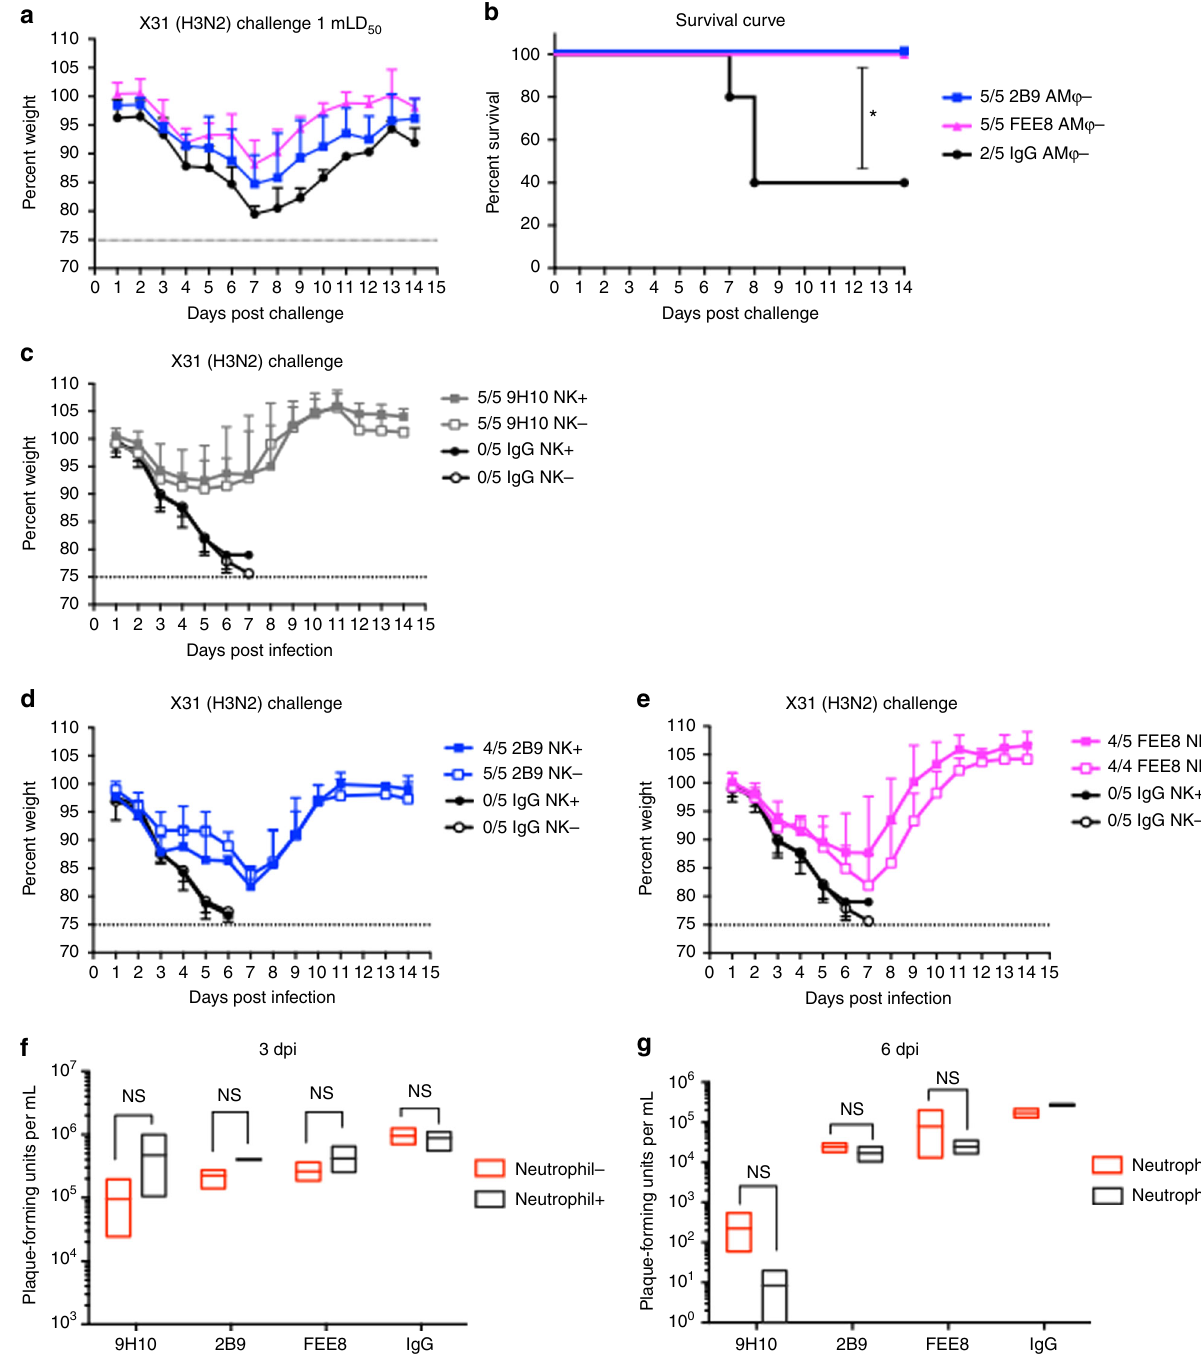
Fig. 4 NK cells and neutrophils do not play signi fi cant roles in murine nonNAb-mediated protection. a , b BALB/c mice depleted of AM φ were administered IP with 2B9, FEE8, or IgG, and then challenged IN with 1 mLD 50 of X31 virus. c – e C57BL/6J mice were treated IP with mAb PK136 to deplete NK1.1 cells. Control mice received PBS. Mice received 15 mg per kg of ( c ) 9H10, ( d ) 2B9, or ( e ) FEE8 IP 5 hours before a challenge with 5 mLD 50 of X31. The ratios in the fi gure legends indicate the number of animals that survived challenge over total number of animals per group ( n = 4 or 5). A mAb against GST was used as an IgG control. f , g BALB/c mice were treated with mAb 1A8 to deplete neutrophils. Control mice received PBS. The mice were given 9H10, 2B9, or FEE8 at 15 mg per kg. At ( f ) 3 and ( g ) 6 dpi, viral lung titers were determined by plaque assays. Two-way ANOVA and Sidak ’ s multiple comparisons tests were used to determine statistical signi fi cance (GraphPad Prism) ( n = 3). Values represent mean ± SD. For all panels: * P ≤ 0.05, ** P ≤ 0.01,